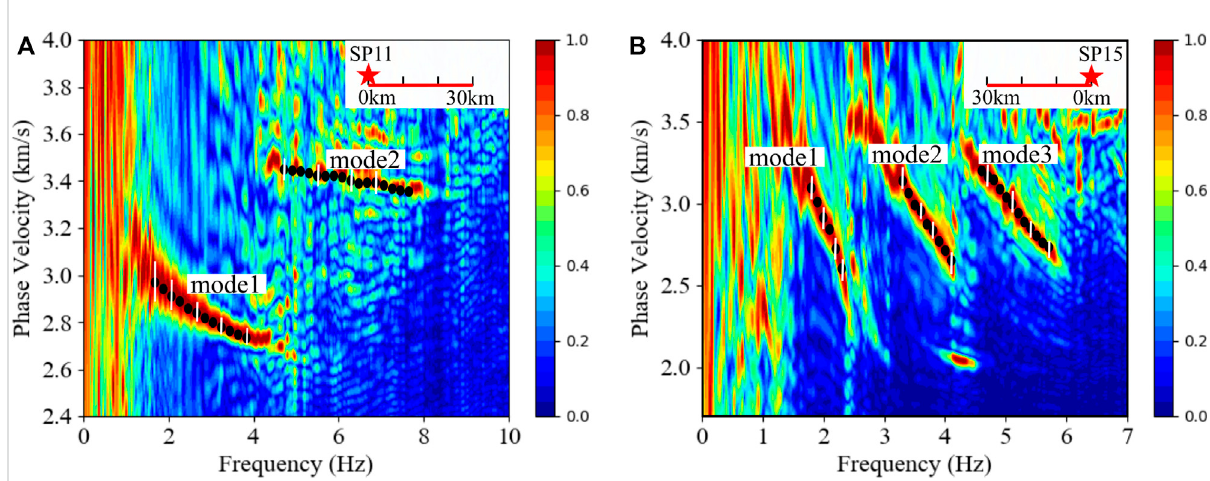
FIGURE 4 The multimodal dispersion curves picked from the F-J spectrograms. The black dots are the picked dispersion curves. The white vertical lines are the uncertainties of the picked dispersion curves. In the upper right corner of each fi gure, the stars represent the sources, and the F-J spectrogramsare extracted from seismicdata on theredlines. (A) Themultimodaldispersioncurvespickedfromthe0 – 30 kmoffset seismic record section of SP11. (B) The multimodal dispersion curves picked from the 0 – 30 km offset seismic record section of